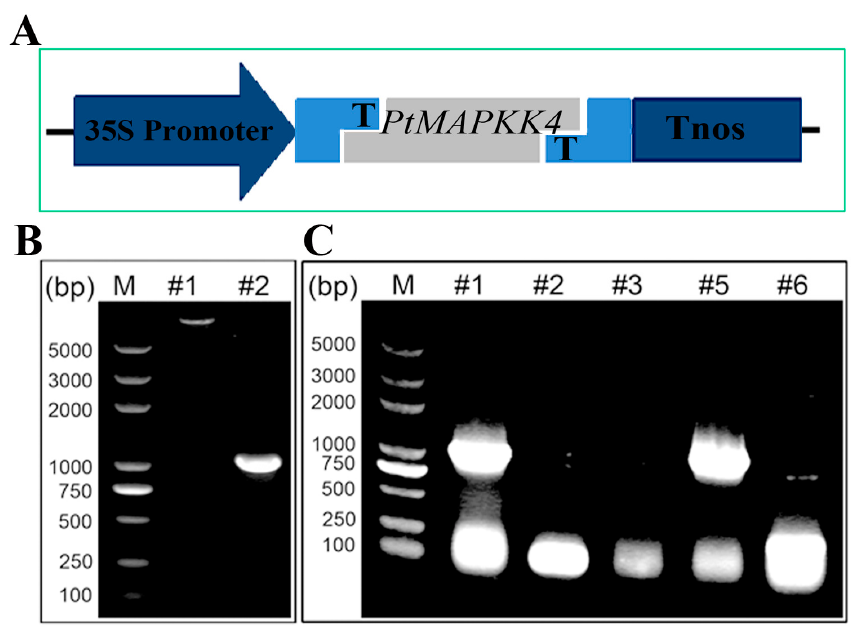
Figure 4. Construction of the plant expression vector pCXSN-PtMAPKK4 plasmid. ( A ) Schematic of expression vectors pCXSN-PTMAPKK4 ; ( B ) The PtMAPKK4 gene was amplified from cDNA of Populus trichocarpa , lane#1, the plasmid of plant expression vector Pcxsn , lane#2, amplification of the PtMAPKK4 gene; ( C ) The PtMAPKK4 gene was amplified from pCXSN-PtMAPKK4 vector for verification, lane#1-6, amplification of PtMAPKK4 in six samples, #1 and #5 were used for transgene.